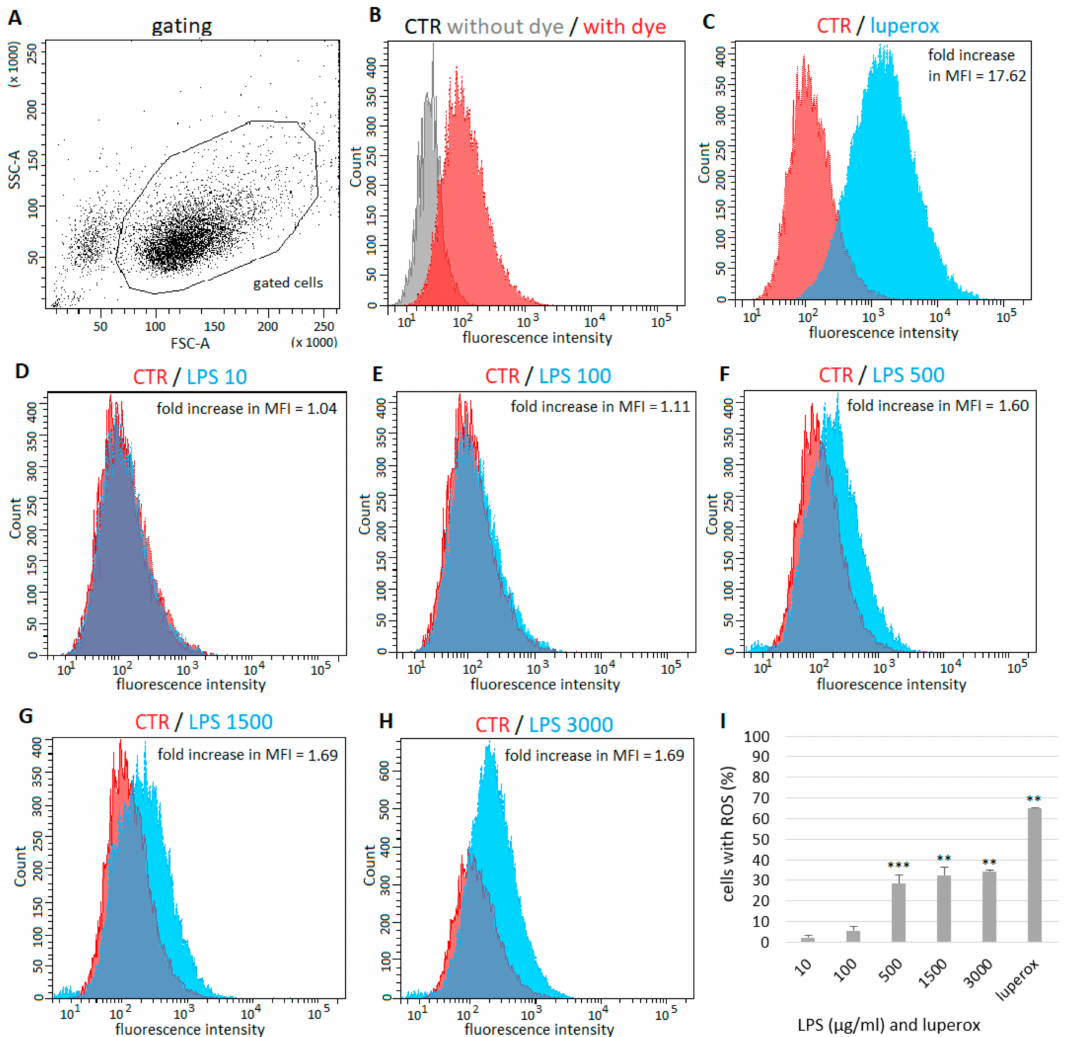
Figure 2. E ff ect of LPS on generation of ROS in A549 cells. Dead cells and debris were eliminated from analysis by live-cell gating. Along the X-axis is the FSC (Forware SCatter) parameter. Along the Y-axis is the SSC(Side SCatter) parameter ( A ). Unstained and untreated cells were included for elimination of non-specific autofluorescence signal ( B ). Compared to control (H 2 DCFDA-loaded but untreated cells), more than 65% of ROS + cells were detected in cells treated with Luperox ( C ), no change in ROS levels in cells treated with low concentration of LPS (10 µ g / mL) was detected ( D ), 6% more ROS + were detected after treatment with LPS at 100 µ g / mL ( E ) and 28%, 33% and 34% increase of ROS + cells was observed in cells exposed to LPS at 500, 1500 and 3000 µ g / mL, respectively ( F – H ). Percentage of ROS + cells is shown on a graph, untreated cells represent basal (zero) line ( I ). Data are presented as means ± SDs from three independent experiments. ** p < 0.01, *** p < 0.001. CTR—control, LPS—lipopolysaccharide, MFI—mean fluorescence intensity, ROS—reactive oxygen